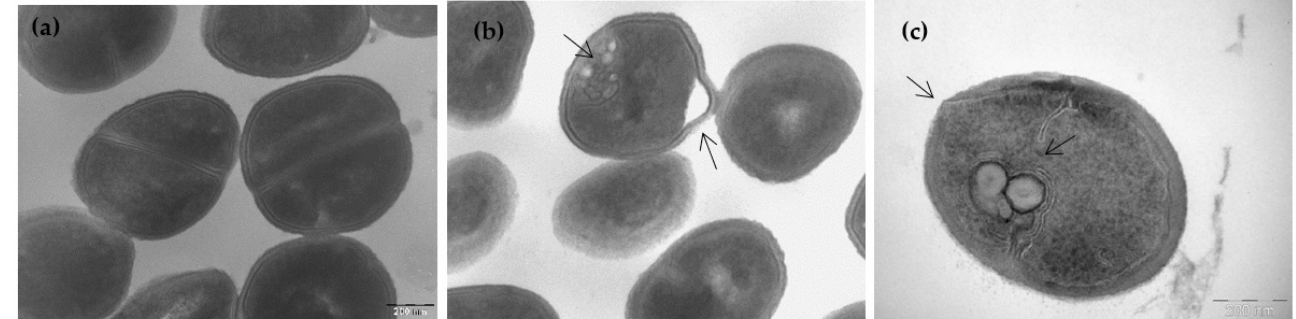
Figure 4. TEM observation of the effect of analogues on S. aureus . ( a ) Untreated cells are round and intact, with a well- defined cell membrane. After treatment with 1xMIC of spB-3 (8 µ g · mL − 1 ) ( b ) or spB-8 (2 µ g · mL − 1 ) ( c ), clear alterations of the cell morphology are observed, with the formation of mesosome-like structures.